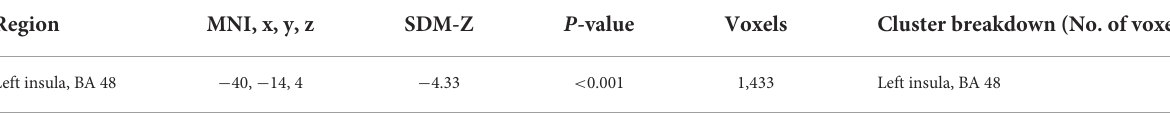
MNI,MontrealNeurologicalInstitute;SDM,signeddifferentialmapping;FWE-correctedP < 0.05,andvoxelextent ≥